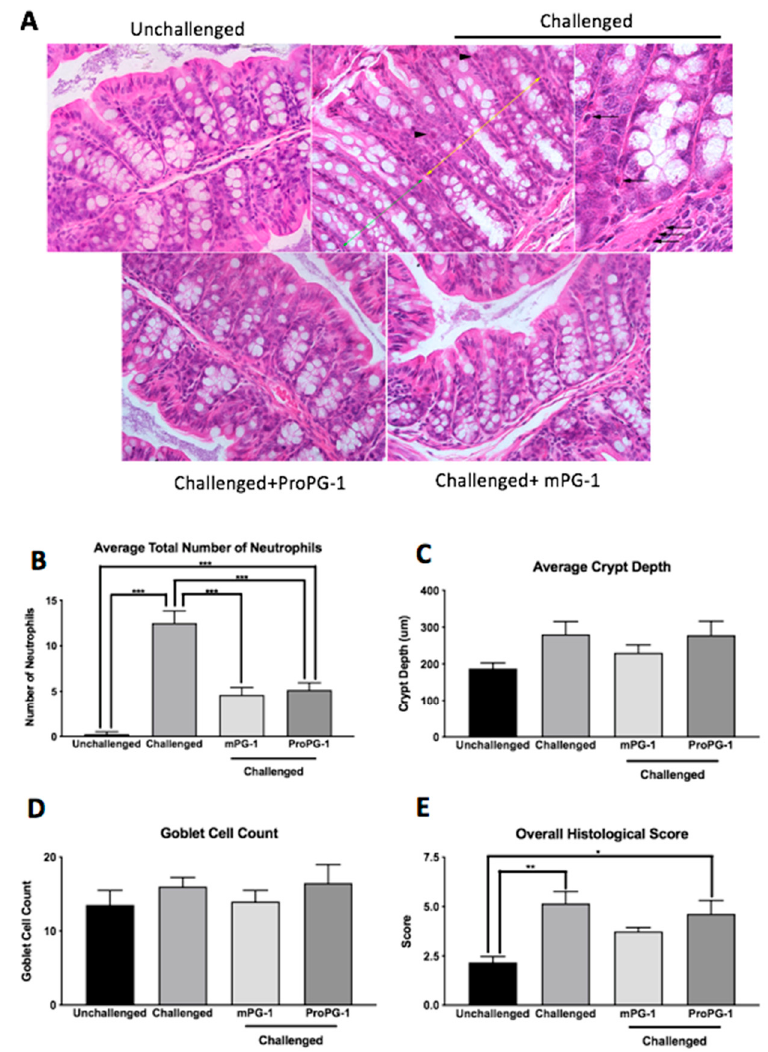
Figure 3. Effects of PG-1 on histologic lesions ( A ) and colonic histomorphology ( B – E ). Distal and proximal colonic sections on Day 10 showed altered mucosal morphology in C. rodentium- challenged mice (upper center and upper right images [enlarged]) compared to unchallenged mice (upper left image). The challenged mice had crypt hyperplasia with loss of goblet cells (yellow arrow–lesional area; green arrow–normal area), necrosis of individual enterocytes (arrowhead), and infiltration of neutrophils (arrows). Both ProPG-1- and mPG-1-treated challenged mice (lower left and right images, respectively) had milder lesions than PBS-treated mice, but mPG-1-treated challenged mice had less immune cell infiltration. Representative hematoxylin-and-eosin-stained sections of colon (magnification: 400x). Compared to untreated mice challenged with C. rodentium , both ProPG- 1- and mPG-1-treated challenged mice had a decrease in ( B ) average total number of neutrophils. No significant differences were observed among treatments for ( C ) average crypt depth or ( D ) goblet cell counts, but both ProPG-1- and mPG-1-treated challenged mice showed a decrease in overall histologic score ( E ). Data represent the mean ± SEM; * p < 0.05, ** p < 0.01, *** p < 0.001 compared to controls; one-way ANOVA post hoc Tukey test.